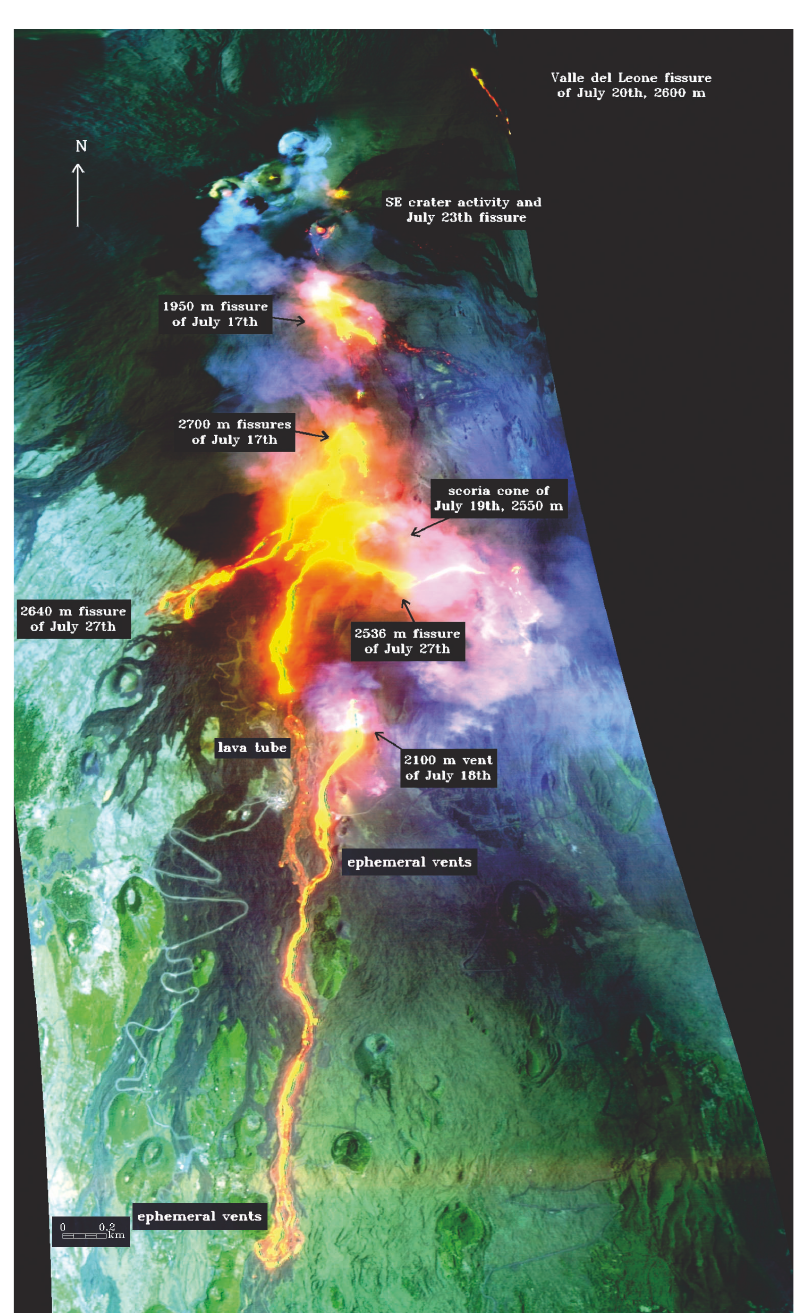
Fig. 2. Geocoded RGB (54, 28, 13) MIVIS bands; average pixel size is 8 × 8